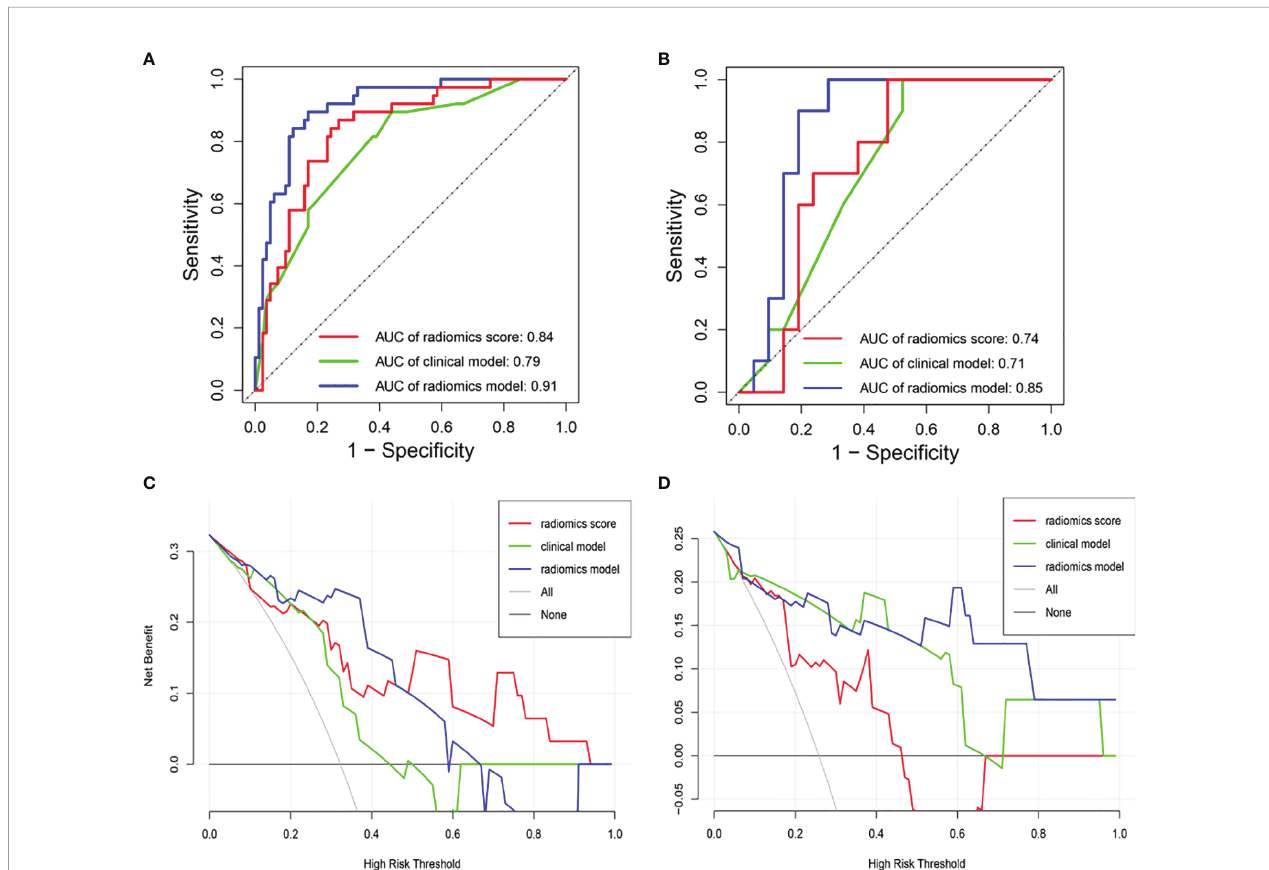
FIGURE 7 | Receiver operating characteristic (ROC) curves of the radiomics score, clinical model, and radiomics model in the (A) training and (B) testing sets. DCA of the three models in (C) the testing set and (D) the temporal validation set. The y-axis measures the net bene fi t. The blue line means the radiomics score. The green line means the clinical model. The red line means the radiomics model. The horizontal black thin line means the assumption that all breast cancer patients were NSLN-positive. The gray line means the assumption that all patients were NSLN-negative. DCA, decision curve